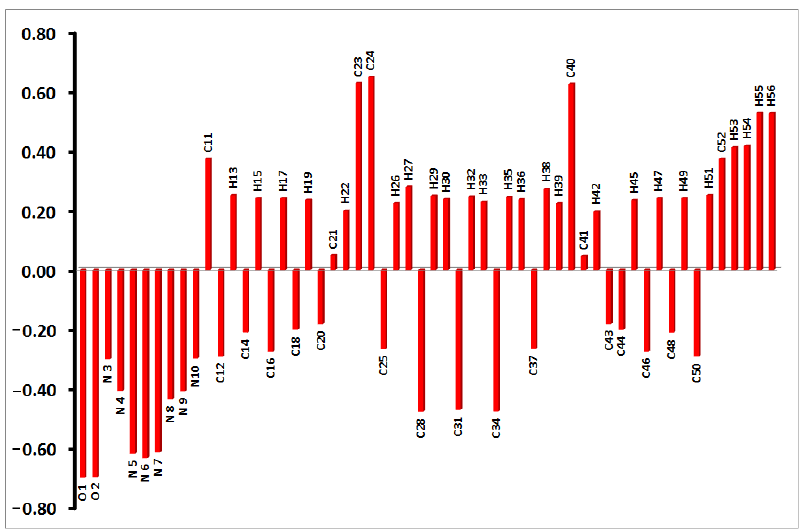
Figure 12. The natural atomic charges in 4.